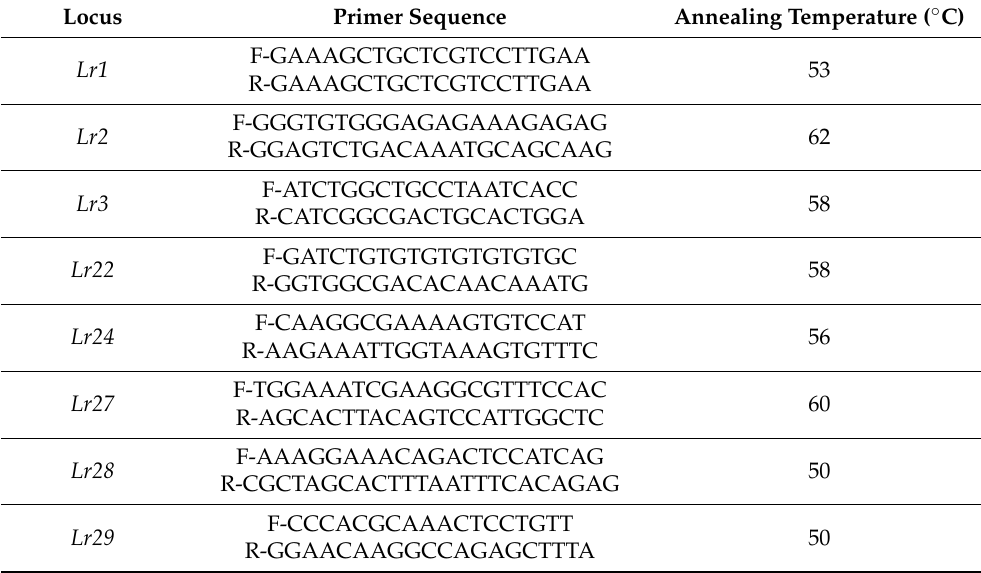
Table 1. Microsatellite primers used for molecular characterization of Ariza labeo ( L. ariza ).